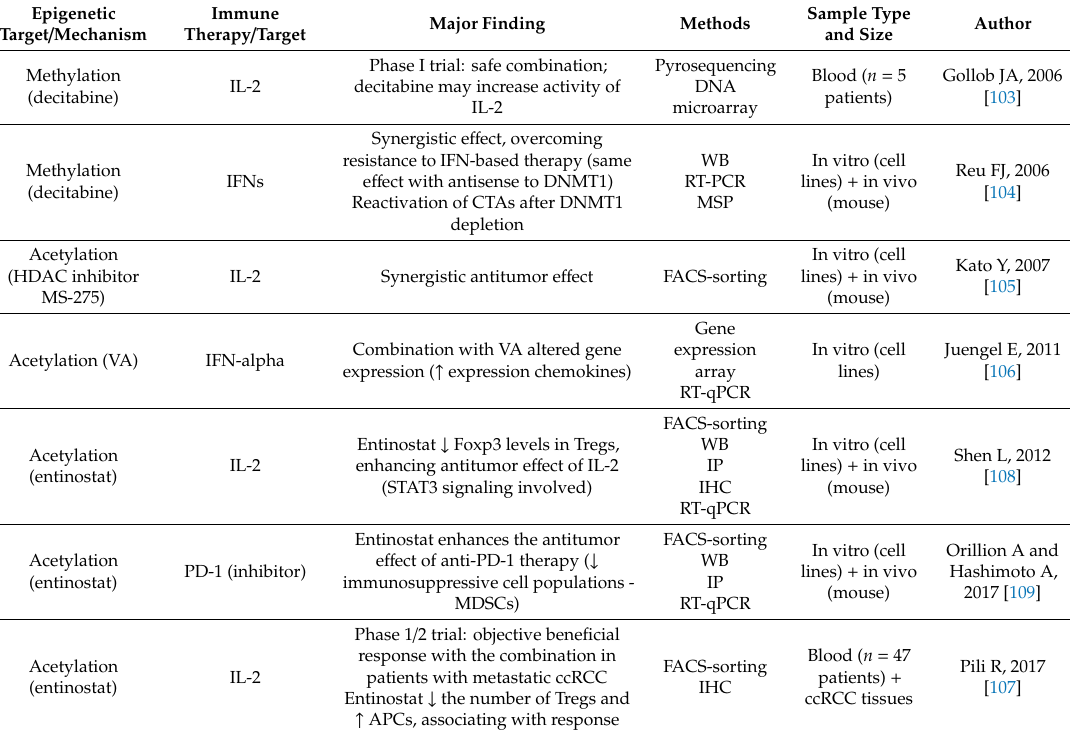
Table 2. Immunoepigenetic-based studies in Kidney